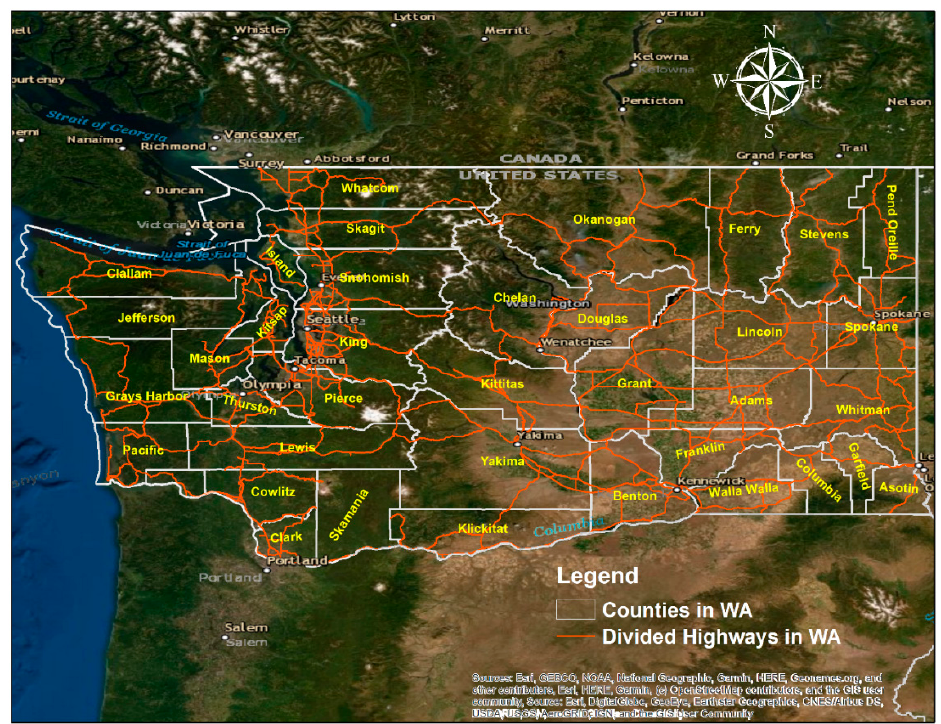
Figure 3. Study area displaying counties and divided highways in Washington State overlaid on top of a satellite imagery base map.